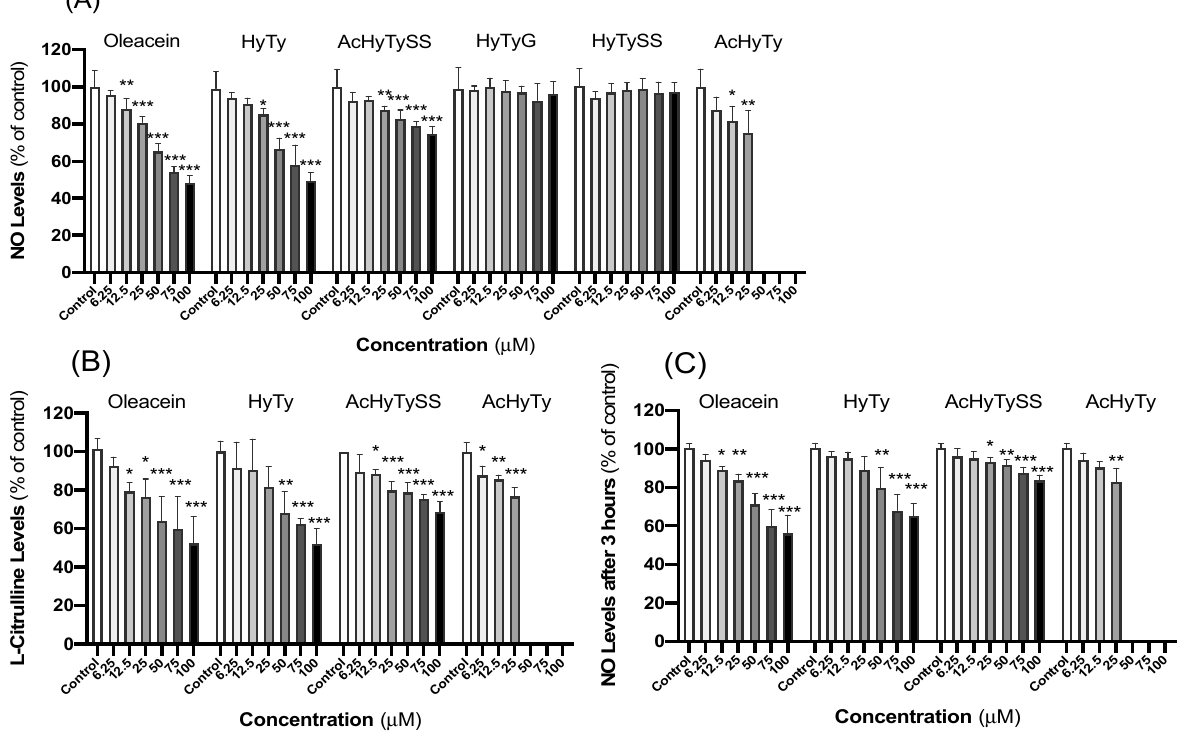
Figure 3. Effects of increasing the concentration of oleacein, HyTy, AcHyTySS, AcHyTy, HyTyG and HyTySS on the production of ● NO ( A ), L-Citrulline ( B ) and ● NO after 3 h ( C ) by LPS-stimulated RAW 264.7 macrophages. Results are expressed as the mean ± SEM of four independent assays, each performed in triplicate. * p < 0.05; ** p < 0.01 and *** p < 0.001 compared to control. Quercetin was used as the positive control.